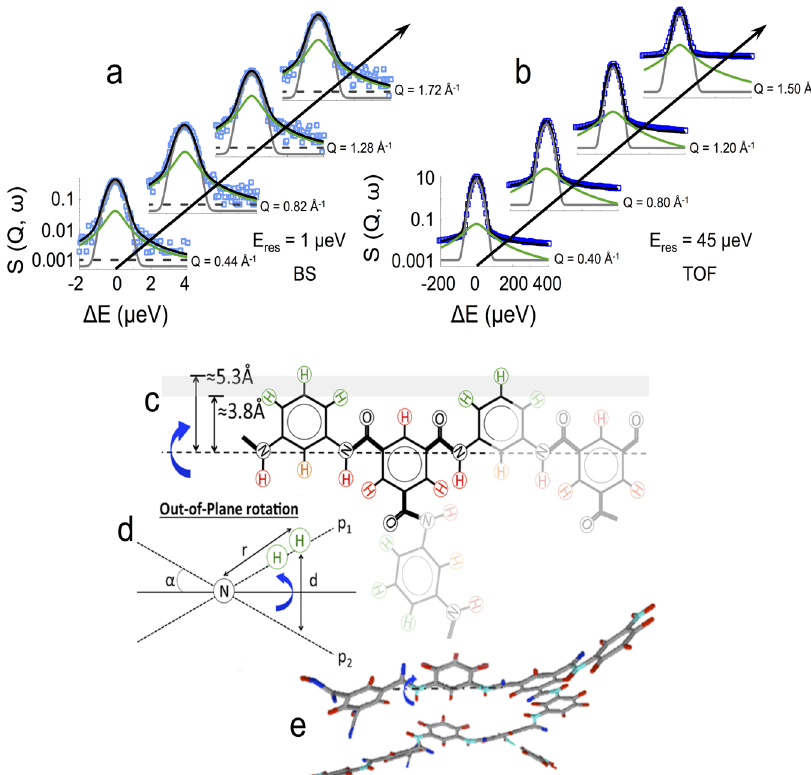
Fig. 2 QENS data and schematic of dry PA relaxation. QENS measurements of dry PA at 330 K measured by ( a) BS, IN16B and ( b ) TOF, IN5 at selected Q -values, depicting the S ( Q , ω ) data, overall fi t (black), instrumental resolution (gray), and Lorentzian pro fi le (green). c Schematic of the chemical structure of highly cross-linked PA, labeling H atoms in the TMC-MPD 1:1.5 unit that are expected to be mobile (green) and immobile (red), indicating the proposed rotational axis and distance to mobile protons. d Cross-section of the out-of-plane rotation used to compute the EISF 39 , and ( e ) corresponding 3D visualization. Source data are available at https://doi.org/10.5291/ILL-DATA.9-11-1809 and